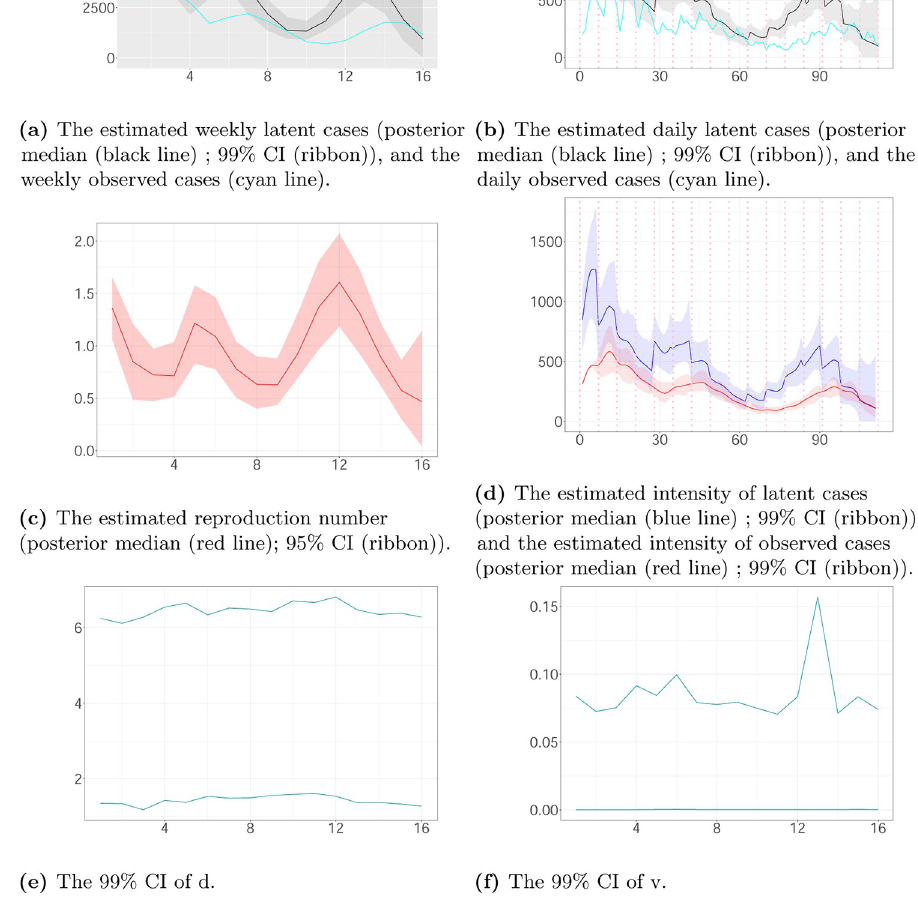
Fig 8. The weekly and daily latent cases, the reproduction number, the latent and observed intensity and the 99% CIs of time-constant parameters in Kingston upon Thames plotted against time. The time interval between two successive pink vertical dashed lines corresponds to a week. (a) The estimated weekly latent cases (posterior median (black line); 99% CI (ribbon)), and the weekly observed cases (cyan line). (b) The estimated daily latent cases (posterior median (black line); 99% CI (ribbon)), and the daily observed cases (cyan line). (c) The estimated reproduction number (posterior median (red line); 95% CI (ribbon)). (d) The estimated intensity of latent cases (posterior median (blue line); 99% CI (ribbon)) and the estimated intensity of observed cases (posterior median (red line); 99% CI (ribbon)). (e) The 99% CI of d. (f) The 99% CI of v.